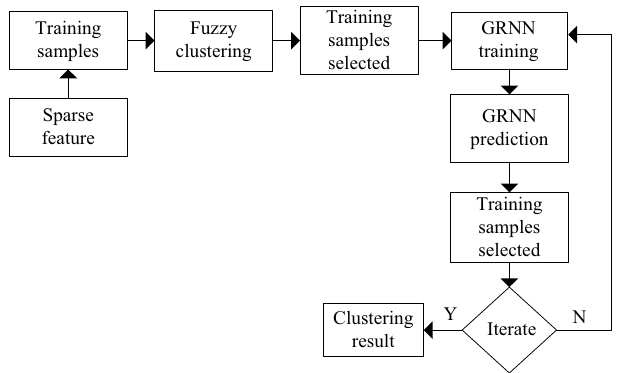
Figure 2. The FCM-GRNN